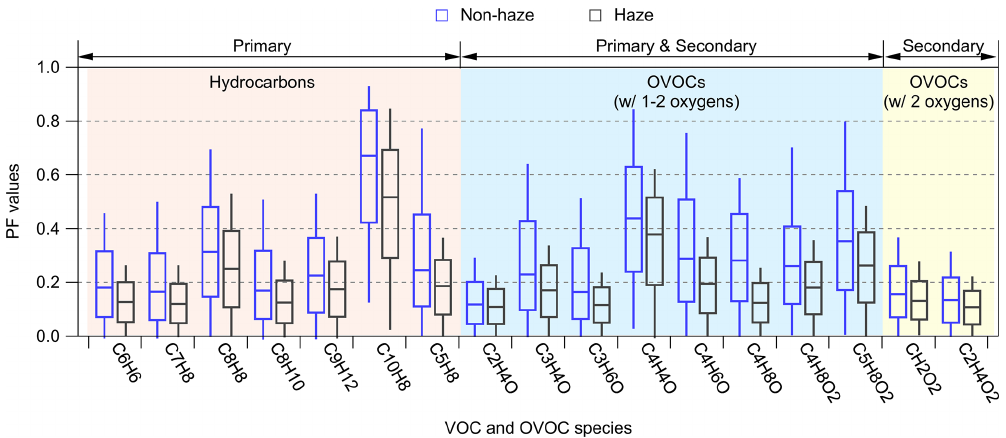
Figure 6. Peak fraction (PF) values for common VOC species measured on the 4th Ring Road in Beijing. Data covered from 09:00 to 16:00 during the measurement period. The box and whisker plots show the median, 75th and 25th percentiles, and 90th and 10th percentiles of PF values calculated for each data